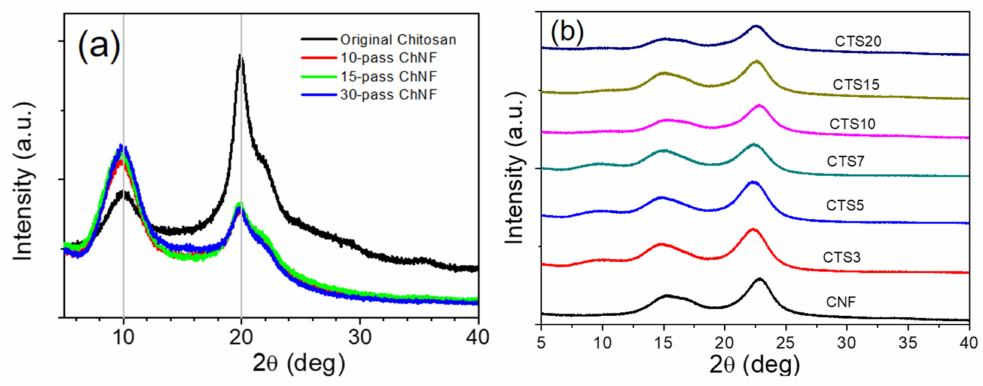
Figure 7. Crystallinity index of: ( a ) ChNF with number of ACC passes; and ( b ) CNF and ChNF–CNF composites.